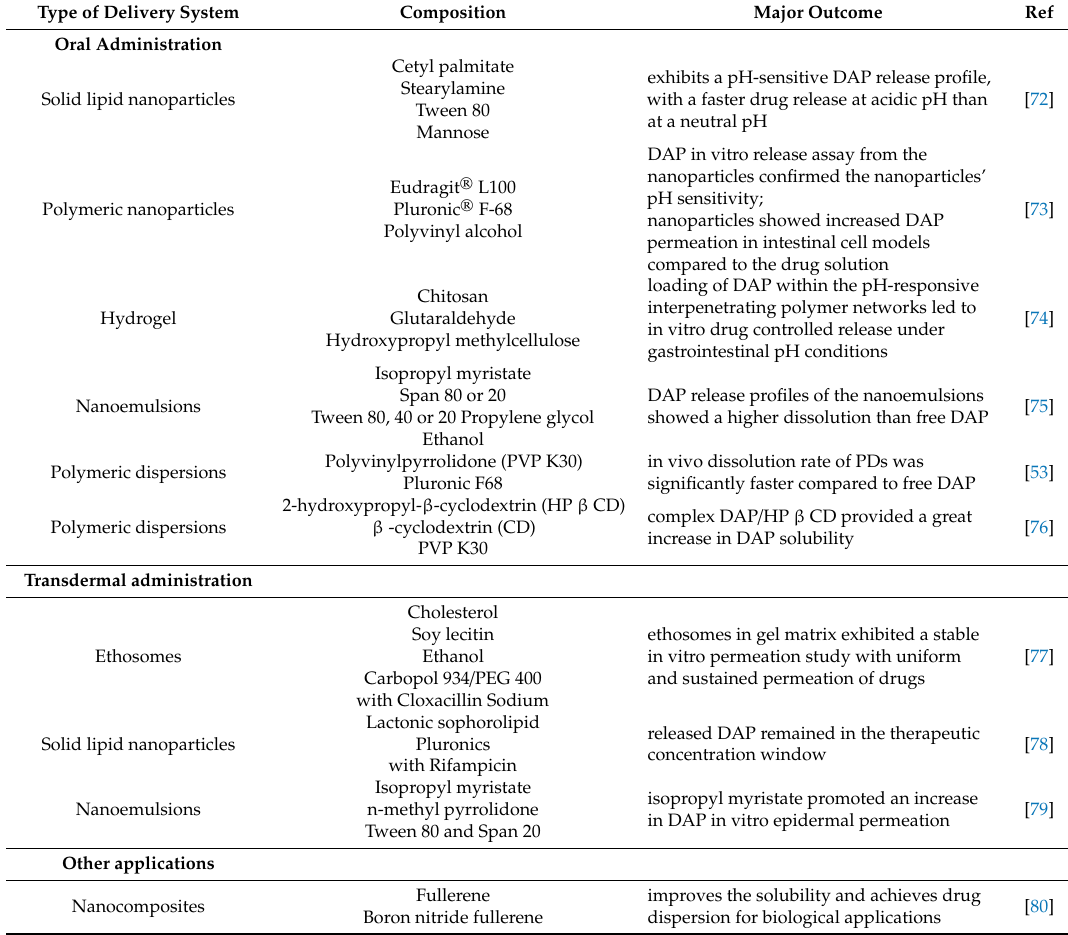
Table 1. Dapsone drug delivery systems for oral and transdermal